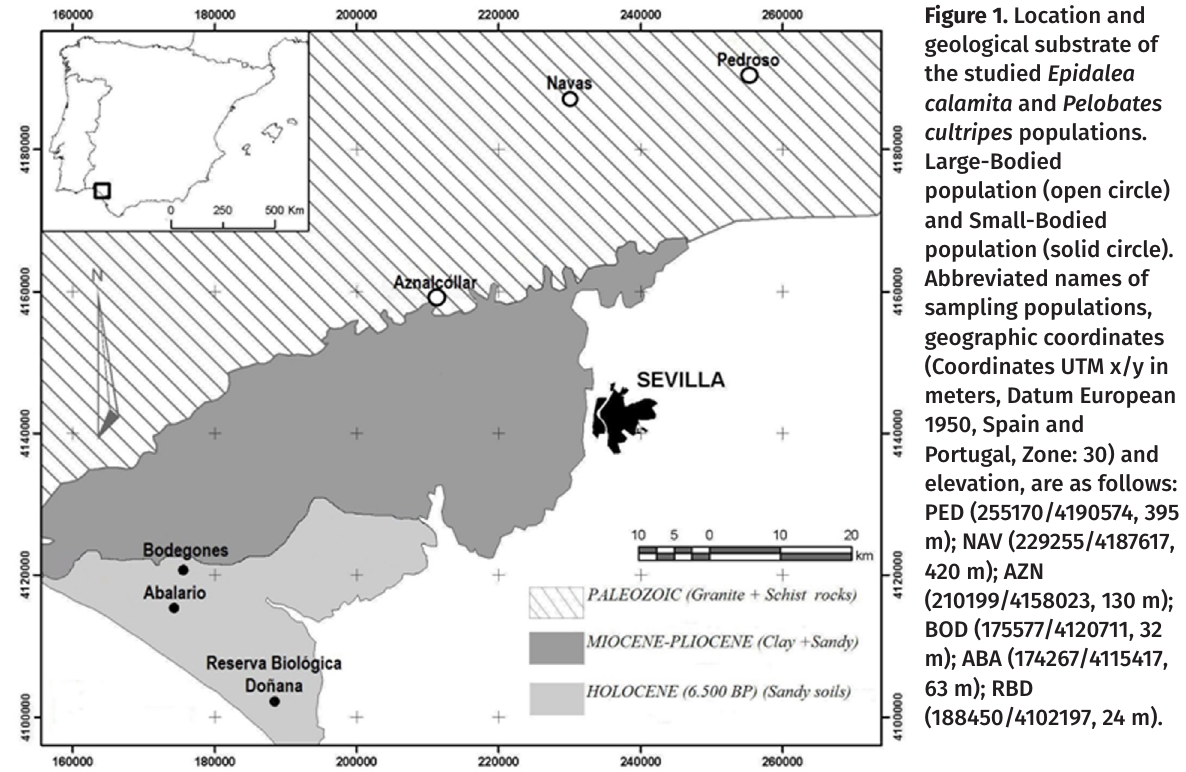
geological substrate